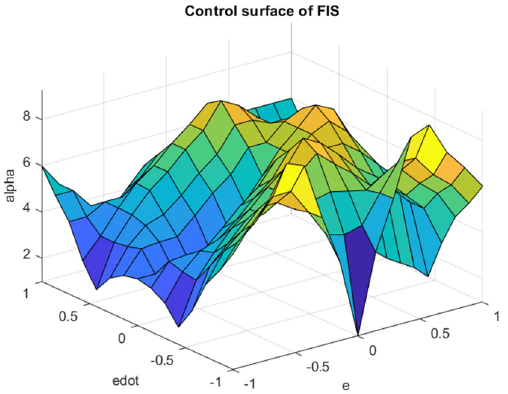
Figure 12. Surface of tuned α fuzzy system.